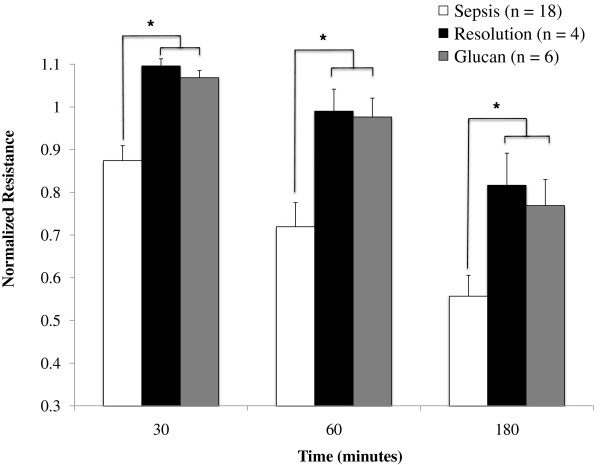
β-Glucan attenuates loss of barrier dysfunction induced by neutrophils from septic patients. Change in monolayer resistance at 30 minutes, 60 minutes, and 180 minutes comparing neutrophil samples from all patients with sepsis (sepsis), samples obtained once sepsis had resolved (resolution), and samples of septic patients’ neutrophils treated with β-glucan (glucan). Groups were analyzed using two-way analysis of variance with Holm–Sidak post-hoc analysis. Values presented as mean ± standard error of the mean. Treatment of neutrophils from septic patients with β-glucan led to an effect upon barrier function that was similar to that induced by neutrophils obtained upon resolution of sepsis; both groups caused less barrier dysfunction than untreated neutrophils from septic patients. *P <0.05 vs. sepsis.